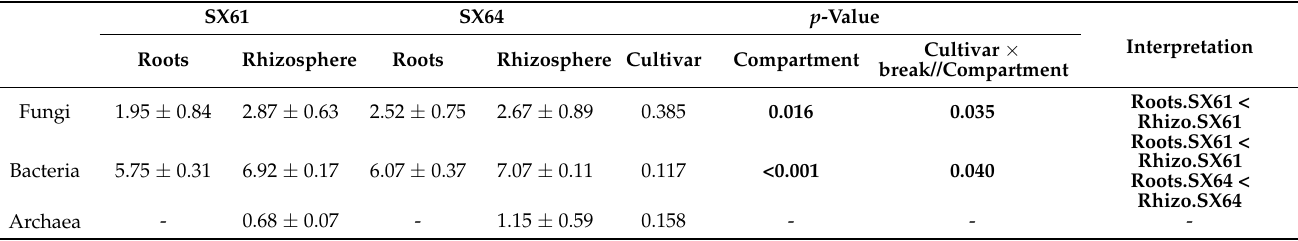
Table 2. Shannon diversity index calculated on ASVs.